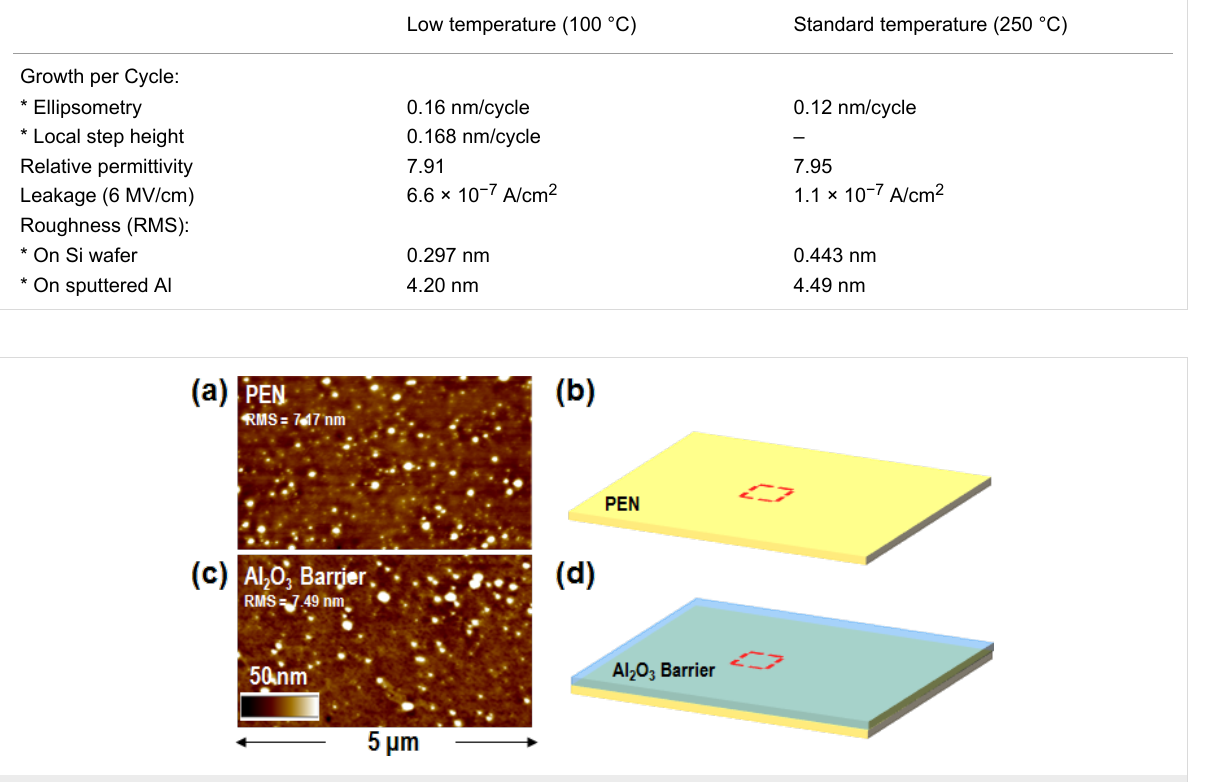
Figure 2: a) Tapping mode atomic force microscopy (tAFM) morphology of the PEN surface and b) a schematic representation of the PEN starting substrate. c) tAFM morphology of the PEN-coated surface by a 100 nm protective Al 2 O 3 layer and d) a schematic representation of the Al 2 O 3 barrier/ PEN